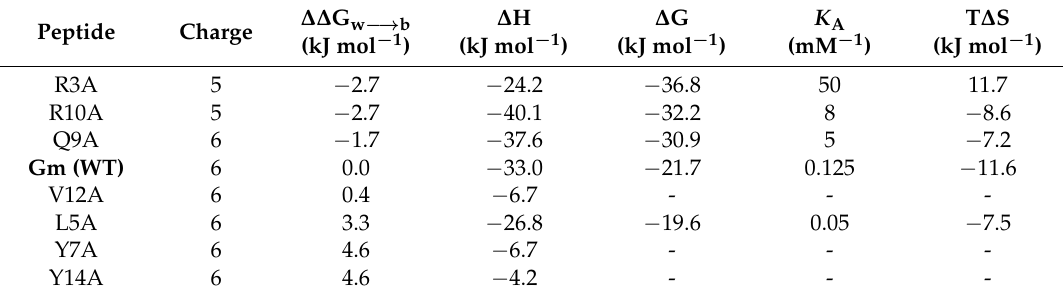
Table 4. List of Gm variants with increased or decreased hydrophobicity, their charge and thermodynamic parameters ( K A , ∆ G, ∆ H and ∆ TS) for binding to POPC–POPG membranes obtained from ITC. ∆∆ G w −→ b is the difference in hydrophobicity between the variant and WT Gm based on an experimentally determined residue-based hydrophobicity scale [53]. Negative values indicate a peptide that is more hydrophobic. Table adapted from Mattei et al. [28]. The binding constant K A , and thus ∆ G and T ∆ S could only be obtained for variants with a ∆ H < − 20 kJ mol − 1 . Peptide